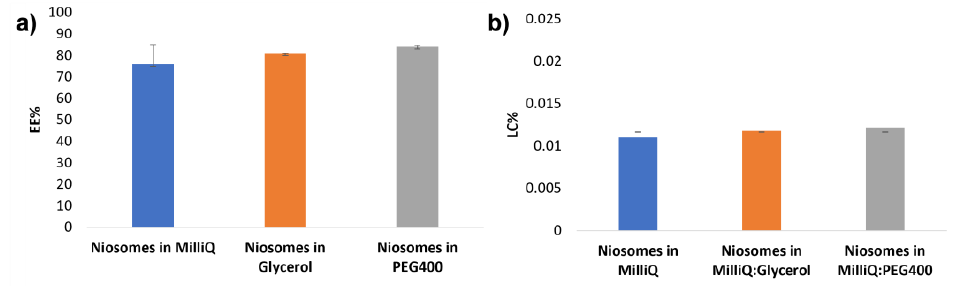
Figure 4. EE ( a ) and LC ( b ) values for the different niosomes formulations of rifamycin S.